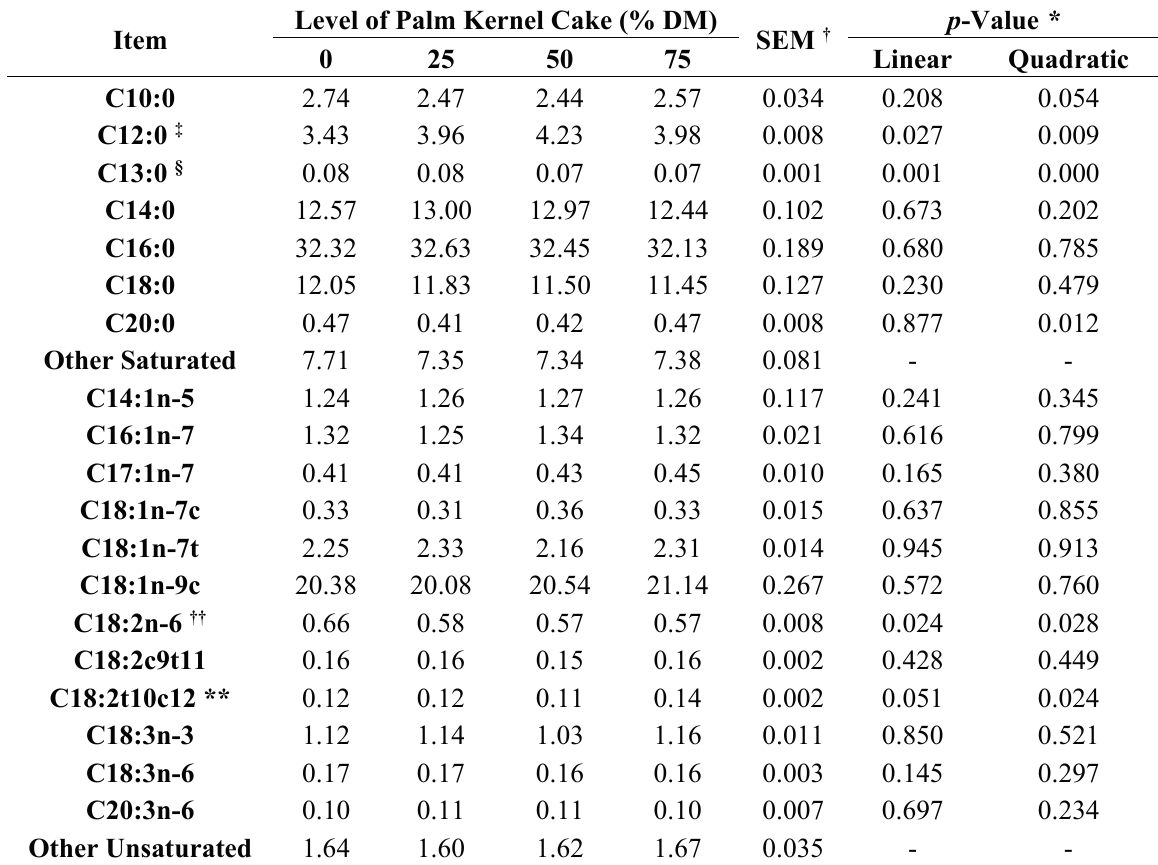
Table 2. The effect of dietary supplementation with differing amounts of palm kernel cake on the fatty acid content (in g/100 g of fatty acids) of milk from cows. Level of Palm Kernel Cake (% Item